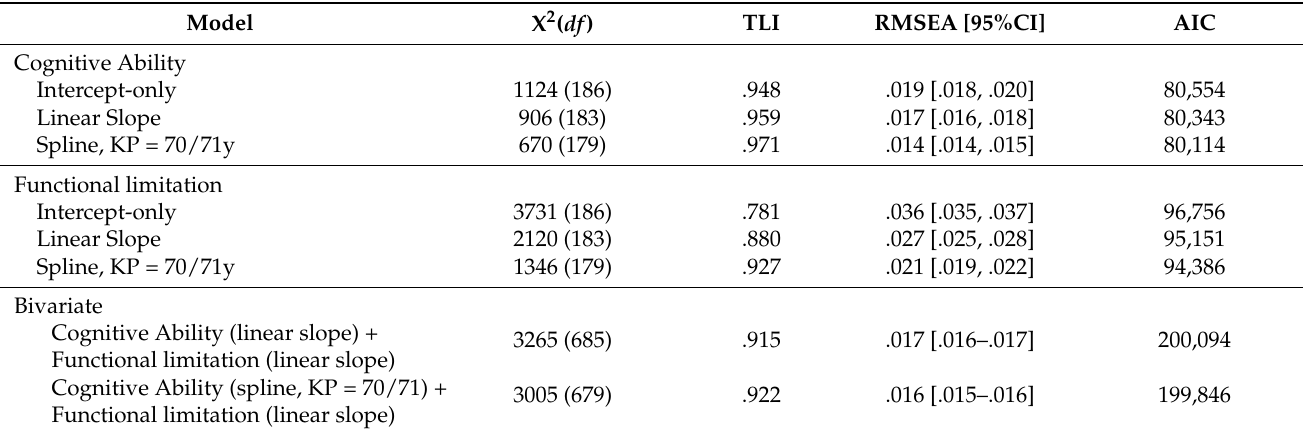
Table 2. Model fit statistics for the latent trajectory